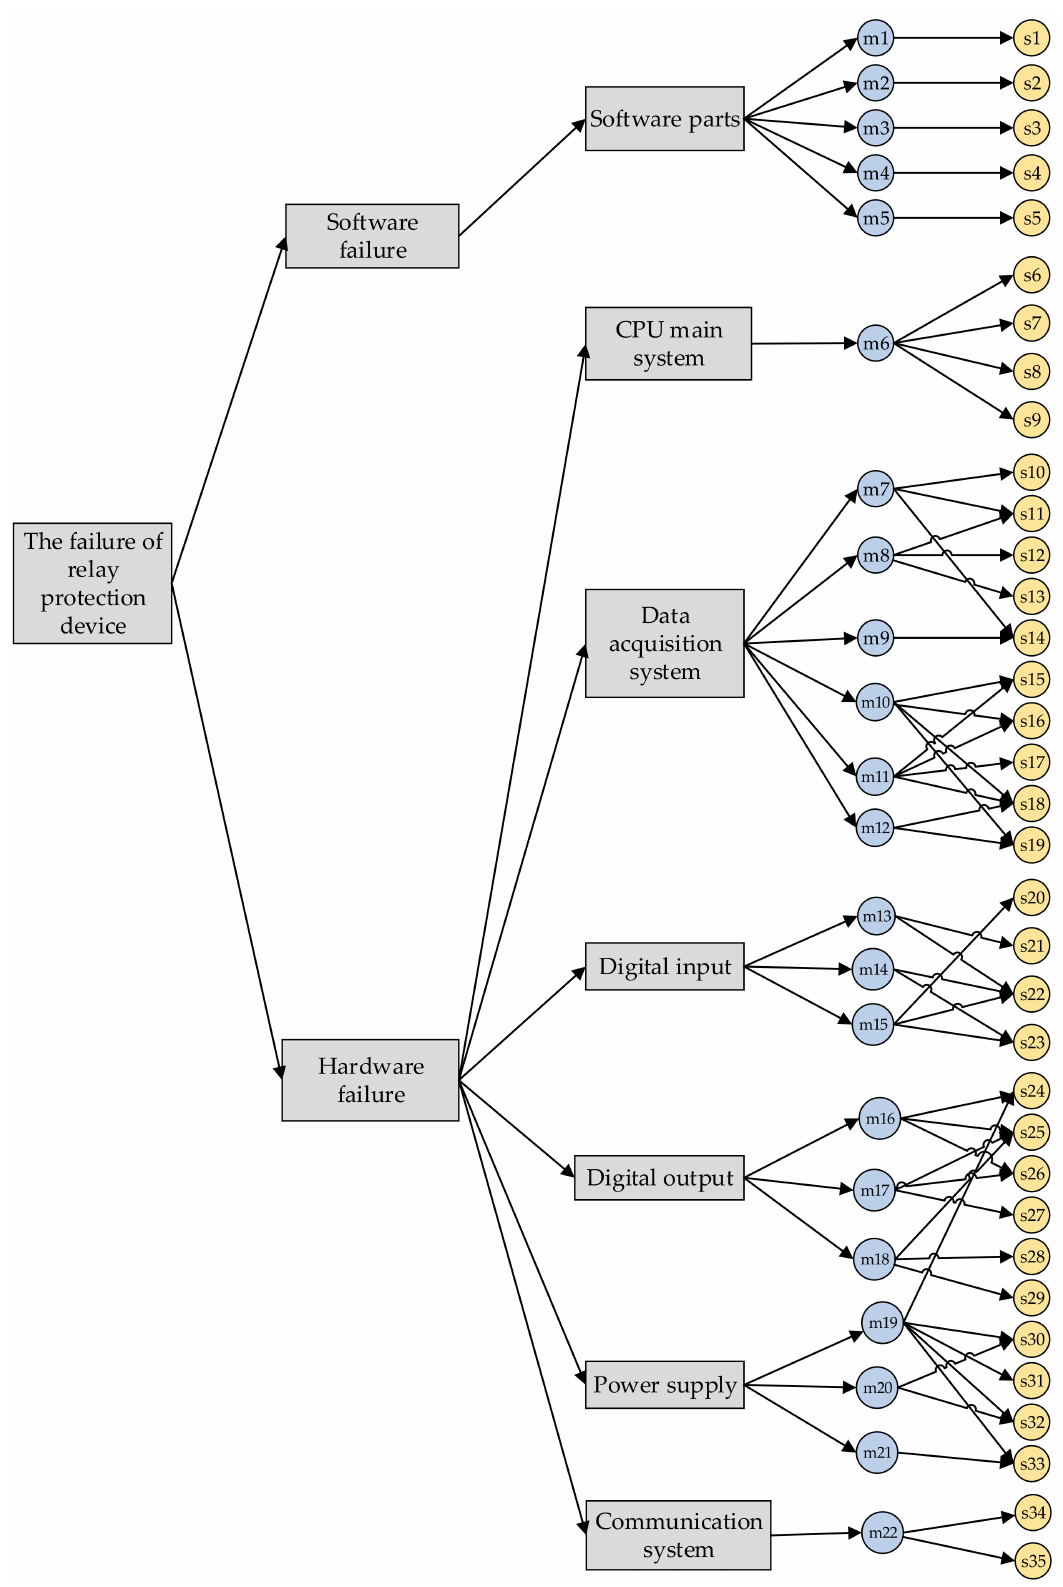
Figure A1. Complete schematic diagram of reasoning chain for relay protection device fault